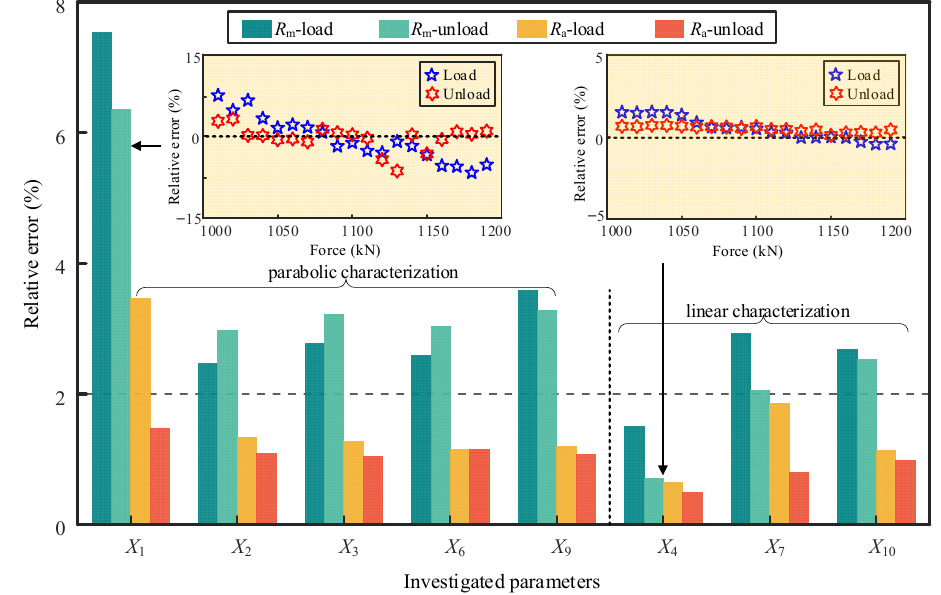
Figure 8. Estimated factor related to the cable force resolution of candidate parameters.